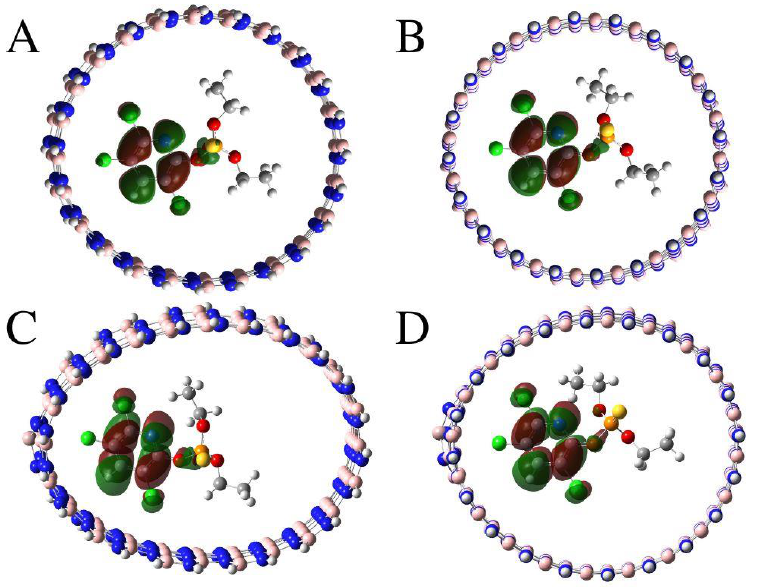
Figure 8. The LUMO diagrams of ( A ) BNNT(12,12) + chl, ( B ) BNNT(20,0) + chl, ( C ) Al-BNNT(12,12) + chl, and ( D ) Al-BNNT(20,0) + chl.